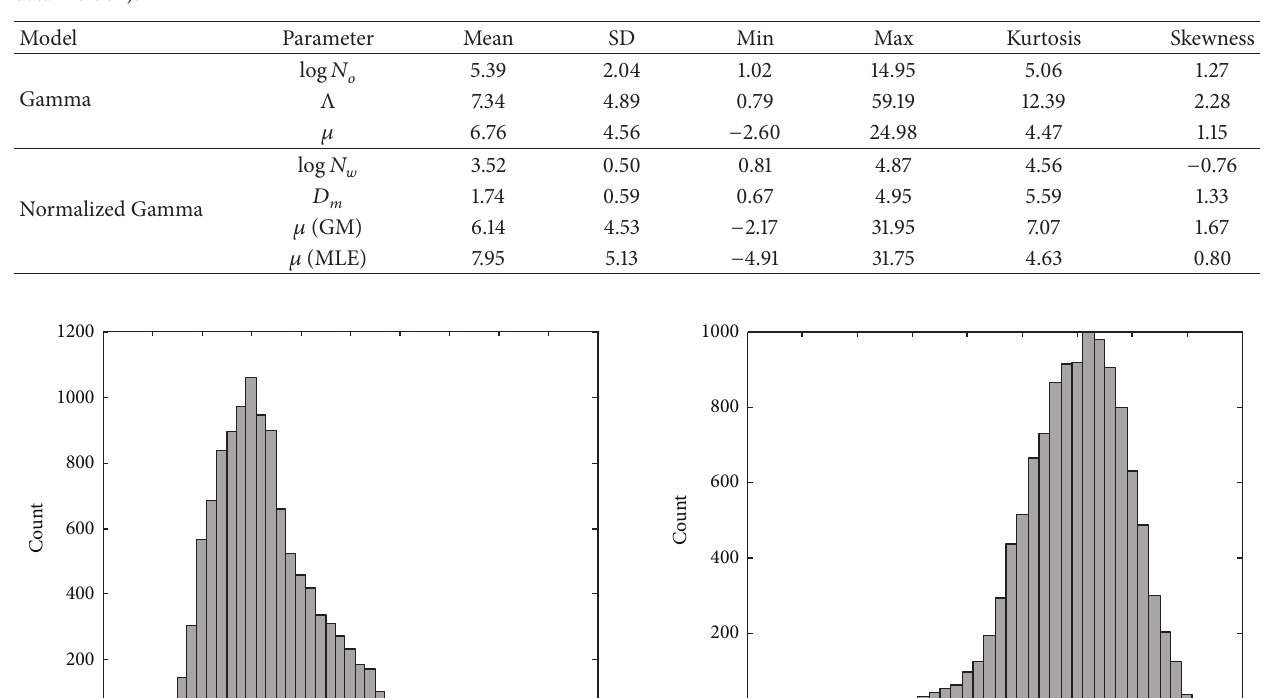
Figure 11: (a) Histogram of estimated 𝜇 parameter by means of Gamma moment method (MoM) for normalized Gamma model. (b) Histogram of estimated 𝜇 parameter by means of maximum likelihood estimation (MLE) method for normalized Gamma model. Table 3: Statistics of DSD parameters derived from disdrometer data (January 1992–December 1994, 1 min rain rate data, total number of data = 61384).